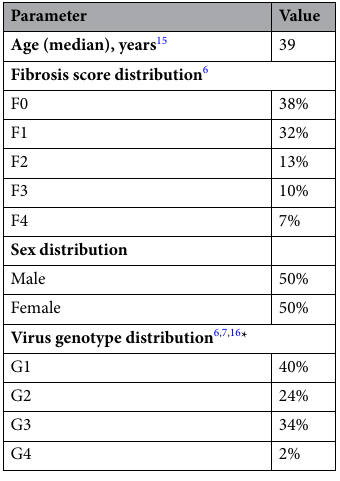
Table 1. Baseline population characteristics among HCV-infected persons in Georgia. HCV hepatitis C virus, F METAVIR fibrosis score, G genotype. *HCV genotypes 5 and 6 were not considered because of their rarity in Georgia. All the distributions in this table, including fibrosis score, sex and genotype were taken as independent of each other and assumed to have no